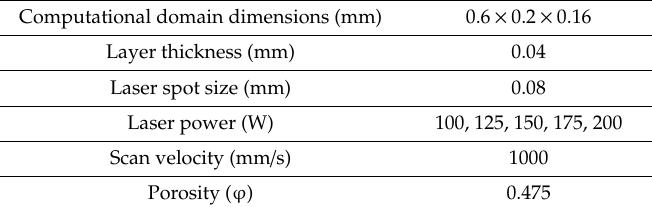
Figure 2. Single scan model geometry. Table 2. Process parameters for simulation.